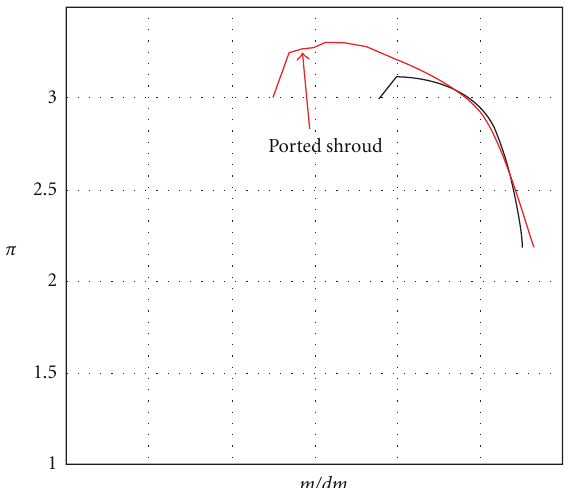
Figure 29: Compressor characteristic with and without ported shroud.